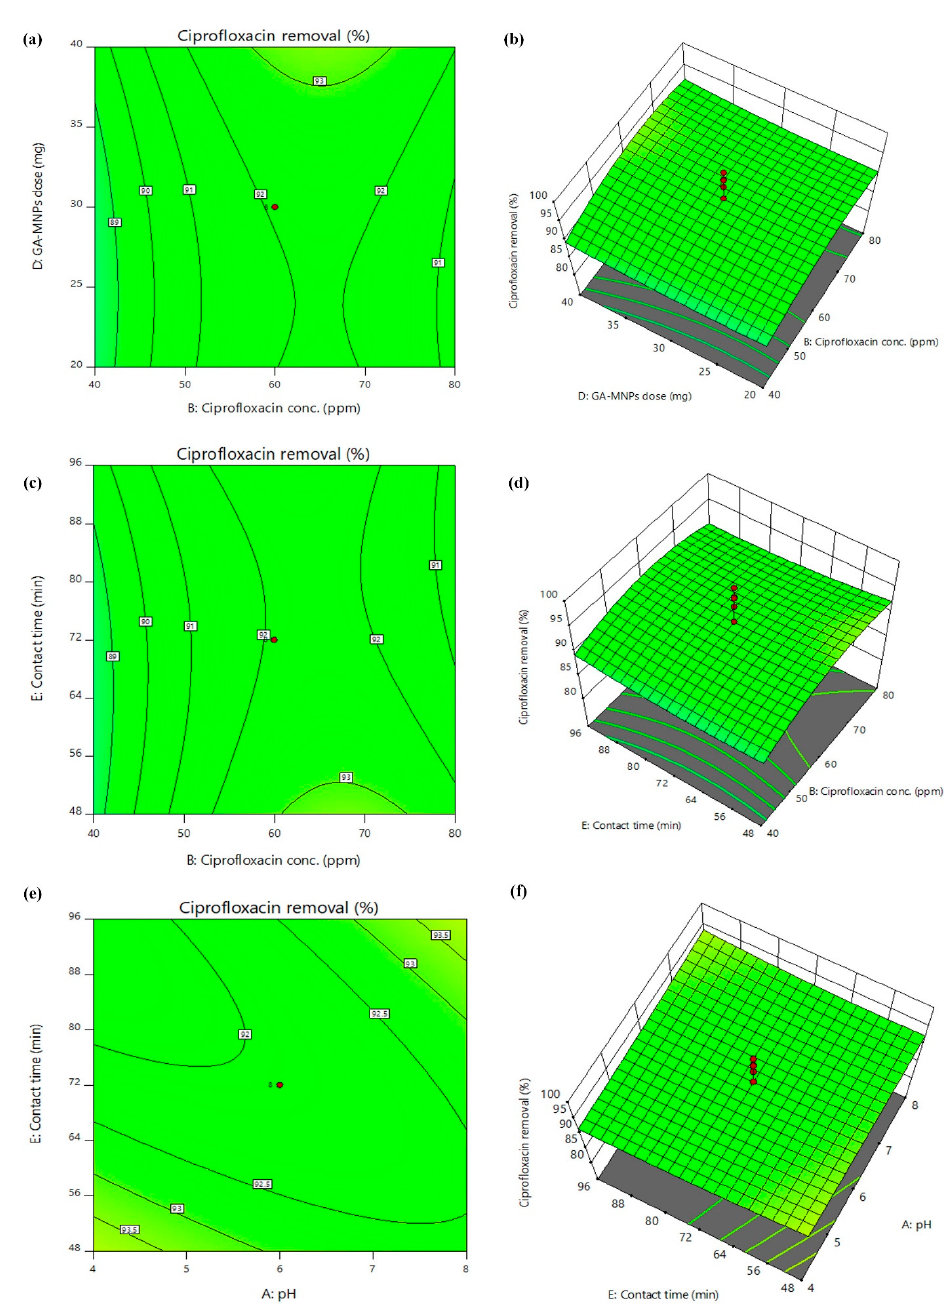
Figure 5. Contour plots and 3D response surface plots of CIP removal reveal the interactive effects of ( a , b ) CIP conc. and GA-MNPs dose, ( c , d ) CIP conc. and contact time, ( e , f ) pH, and contact time.